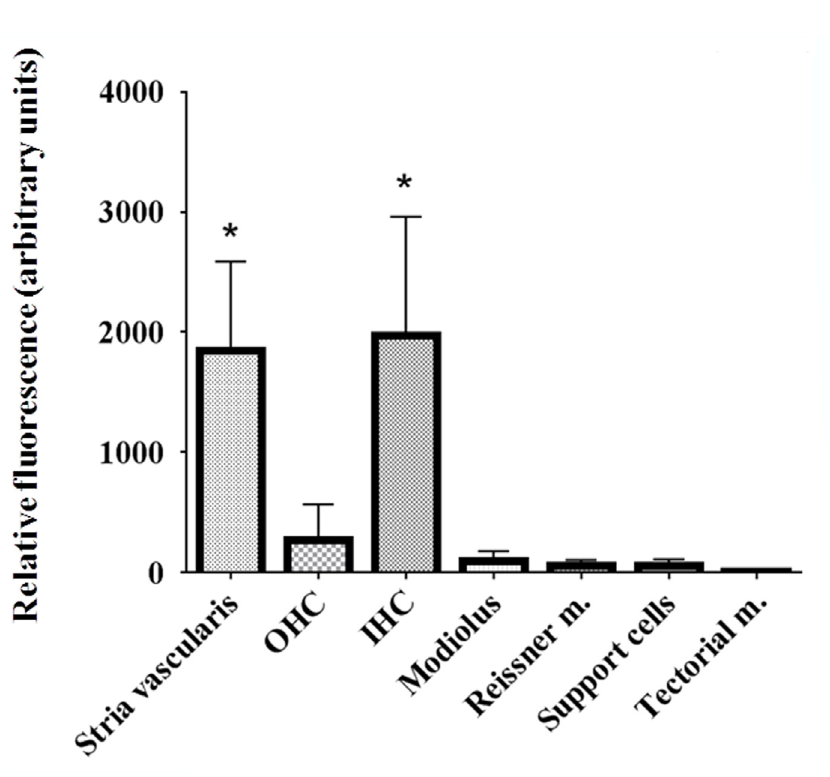
Fig 6. Relative quantification of CB 2 immunofluorescence labeling intensity in different structures of the cochlea by ImageJ. Support cells: supporting cells (including Deiters ’ , Hensen ’ s, Claudius and pillar cells). Tectorial m: tectorial membrane (acellular). Reissner m.: Reissner membrane. OHC: outer hair cells. IHC: inner hair cells. Relative immunofluorescence in the IHC and in the stria vascularis was significantly than in the other cell types. The diagrams include the mean, the standard deviation (n = 10), and the ANOVA results (difference statistically significant respect tectorial membrane * p < 0.05).